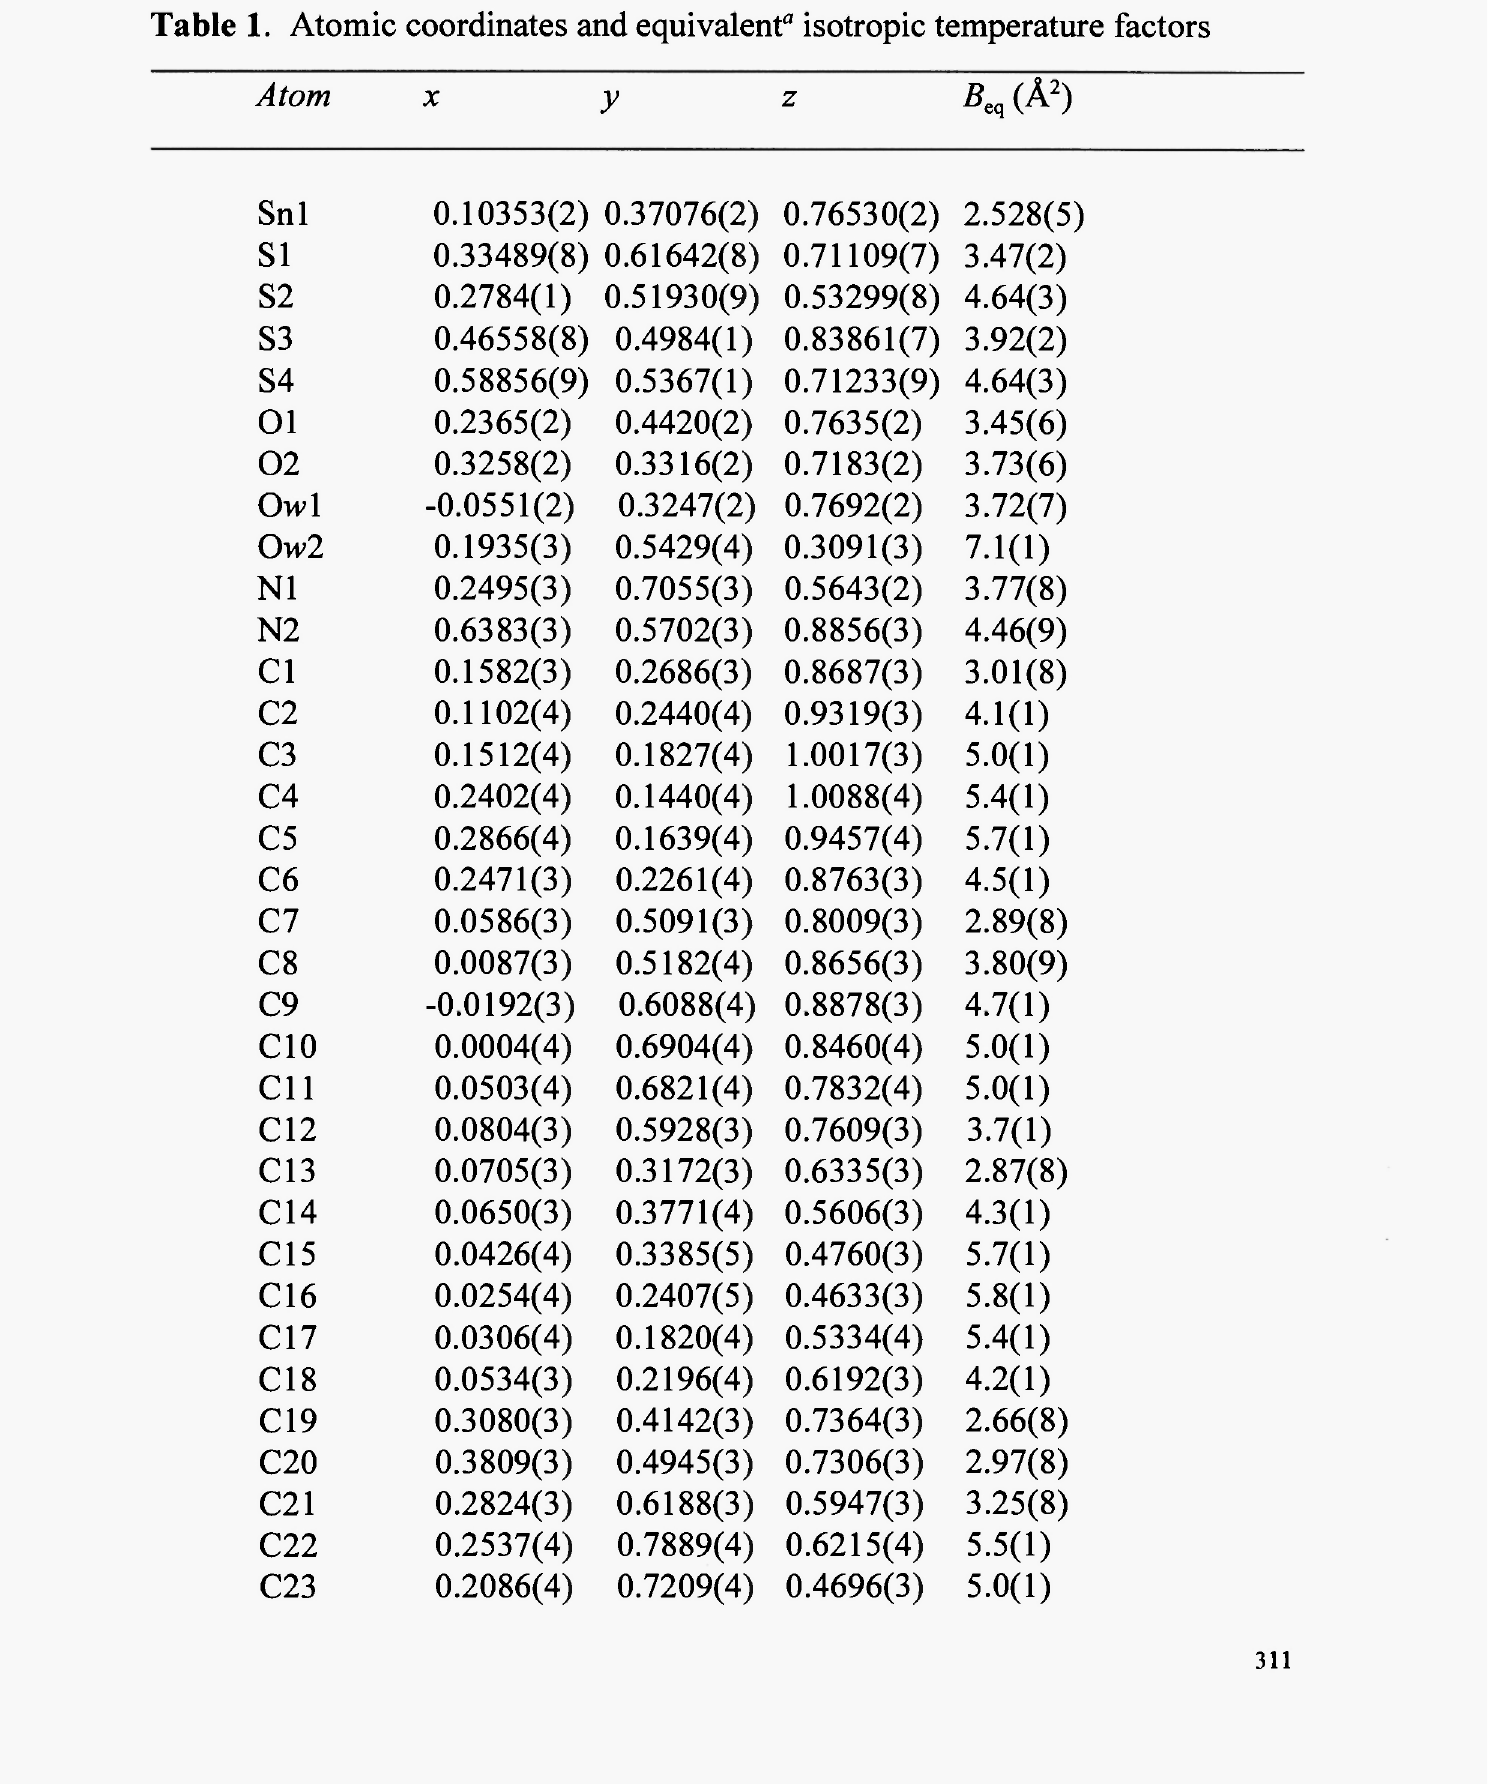
Table 1. Atomic coordinates and equivalent 0 isotropic temperature